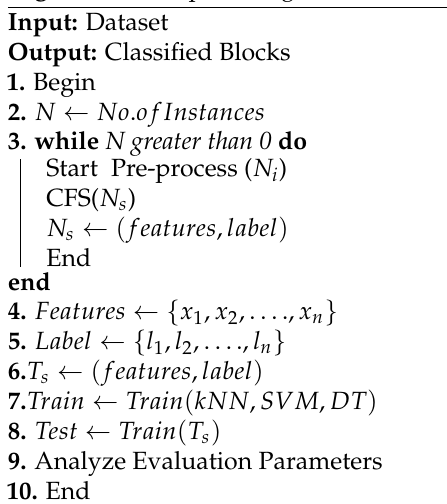
Algorithm 1 Proposed algorithm for Classification